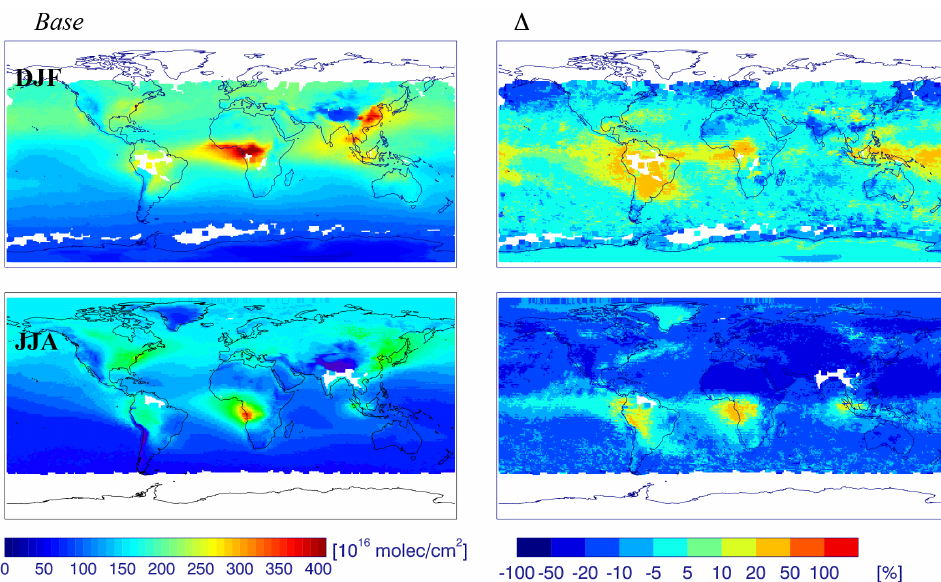
Figure 12. Seasonal mean (2006–2007) CO columns ( × 10 16 moleculescm − 2 ) from the Base scenario (left column) and the relative differ- ence (%; ( Base observations) / observations; right column) with MOPITT